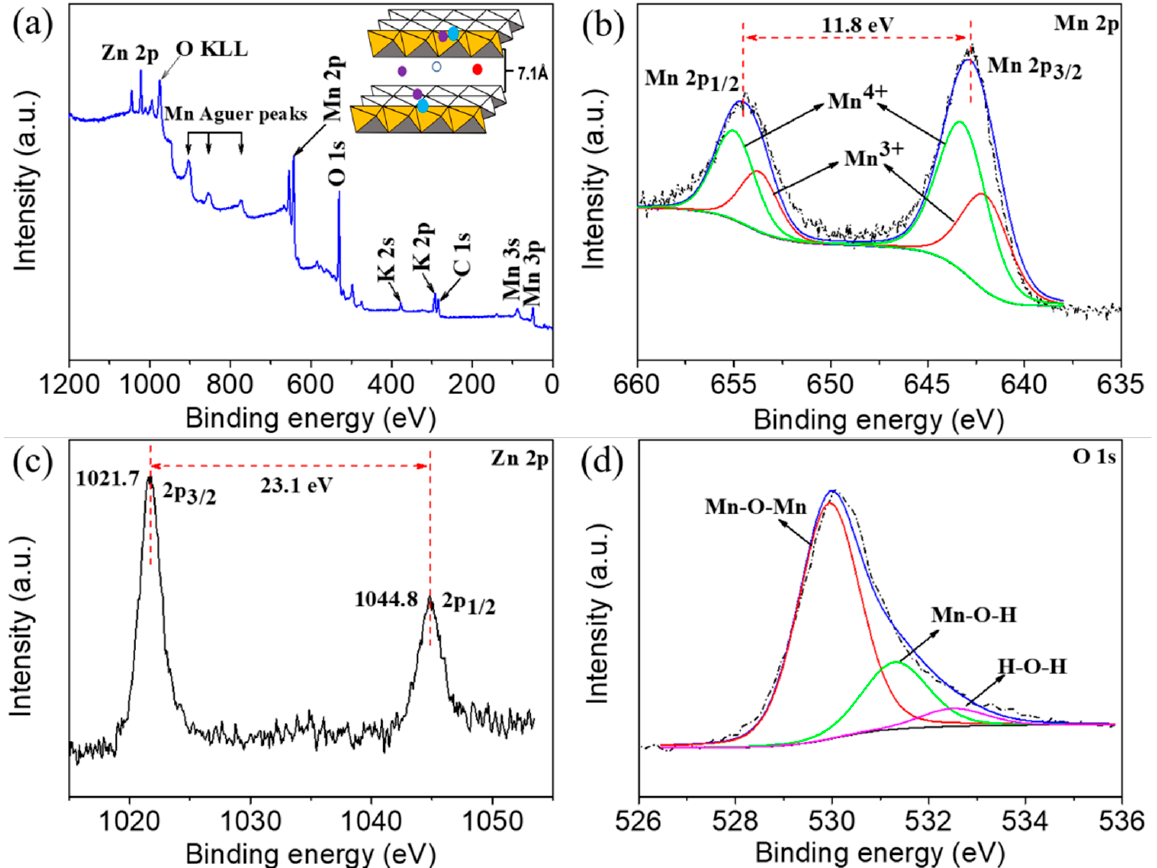
Figure 3. XPS spectra of the Mn10Zn sample: ( a ) survey scan, ( b ) Mn 2p, ( c ) Zn 2p, and ( d ) O 1s. The value of the specific capacitance for electrode materials reflects the prospect of practical applicability to some extent. In this study, we employed galvanostatic charge/ discharge (GCD), cyclic voltammetry (CV), and impedance experiments to assess the electrochemical application of layered MO x - δ -MnO 2 (M = Co, Ni, Zn, Ce) bimetallic ma- terials in 1 M Na 2 SO 4 aqueous solution. Figure 4a,b provide the GCD profiles of layered MO x - δ -MnO 2 with the same Mn/M ratio of 8 and of the lamellar Zn-decorated MnO 2 nanocrystal with a different doping level, respectively. It was found that zinc doping with a Mn/Zn ratio of 8 resulted in the best improvement of the specific capacitance and a higher value 163.6 F/g compared to the parent MnO 2 (153.7 F/g) and other heteroatomic modu- lations, while the Mn8Ce afforded a much-diminished specific capacitance of 108.6 F/g, manifesting the negative doping effect. It can be noted that the improved